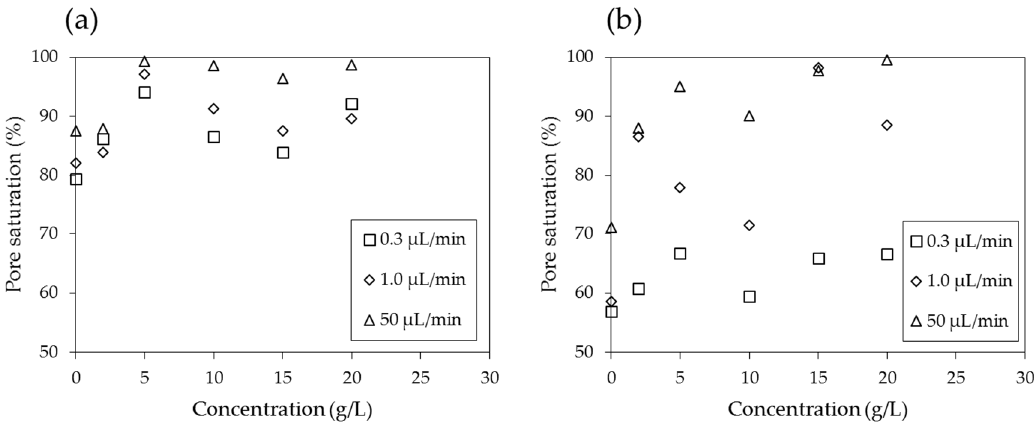
Figure 13. Displacement ratio with respect to concentration in ( a ) an air saturated model and ( b ) a decane saturated model.